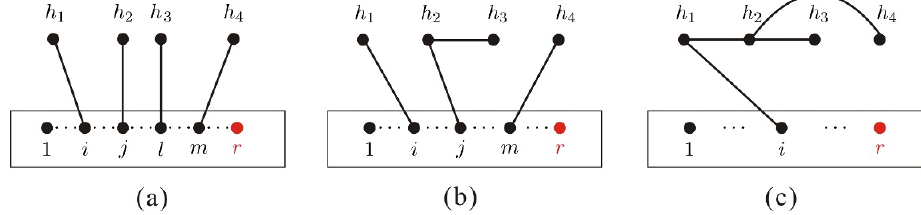
Figure 4 . Examples of old-version graphs for the gauge invariance induced identity eq. (2.9). Here, the node h 4 denotes k (cid:22) , while the nodes h 1 , h 2 and h 3 denote (cid:15) (cid:22) h 4 color the element r by red to remind that the element r always plays as the rightmost element